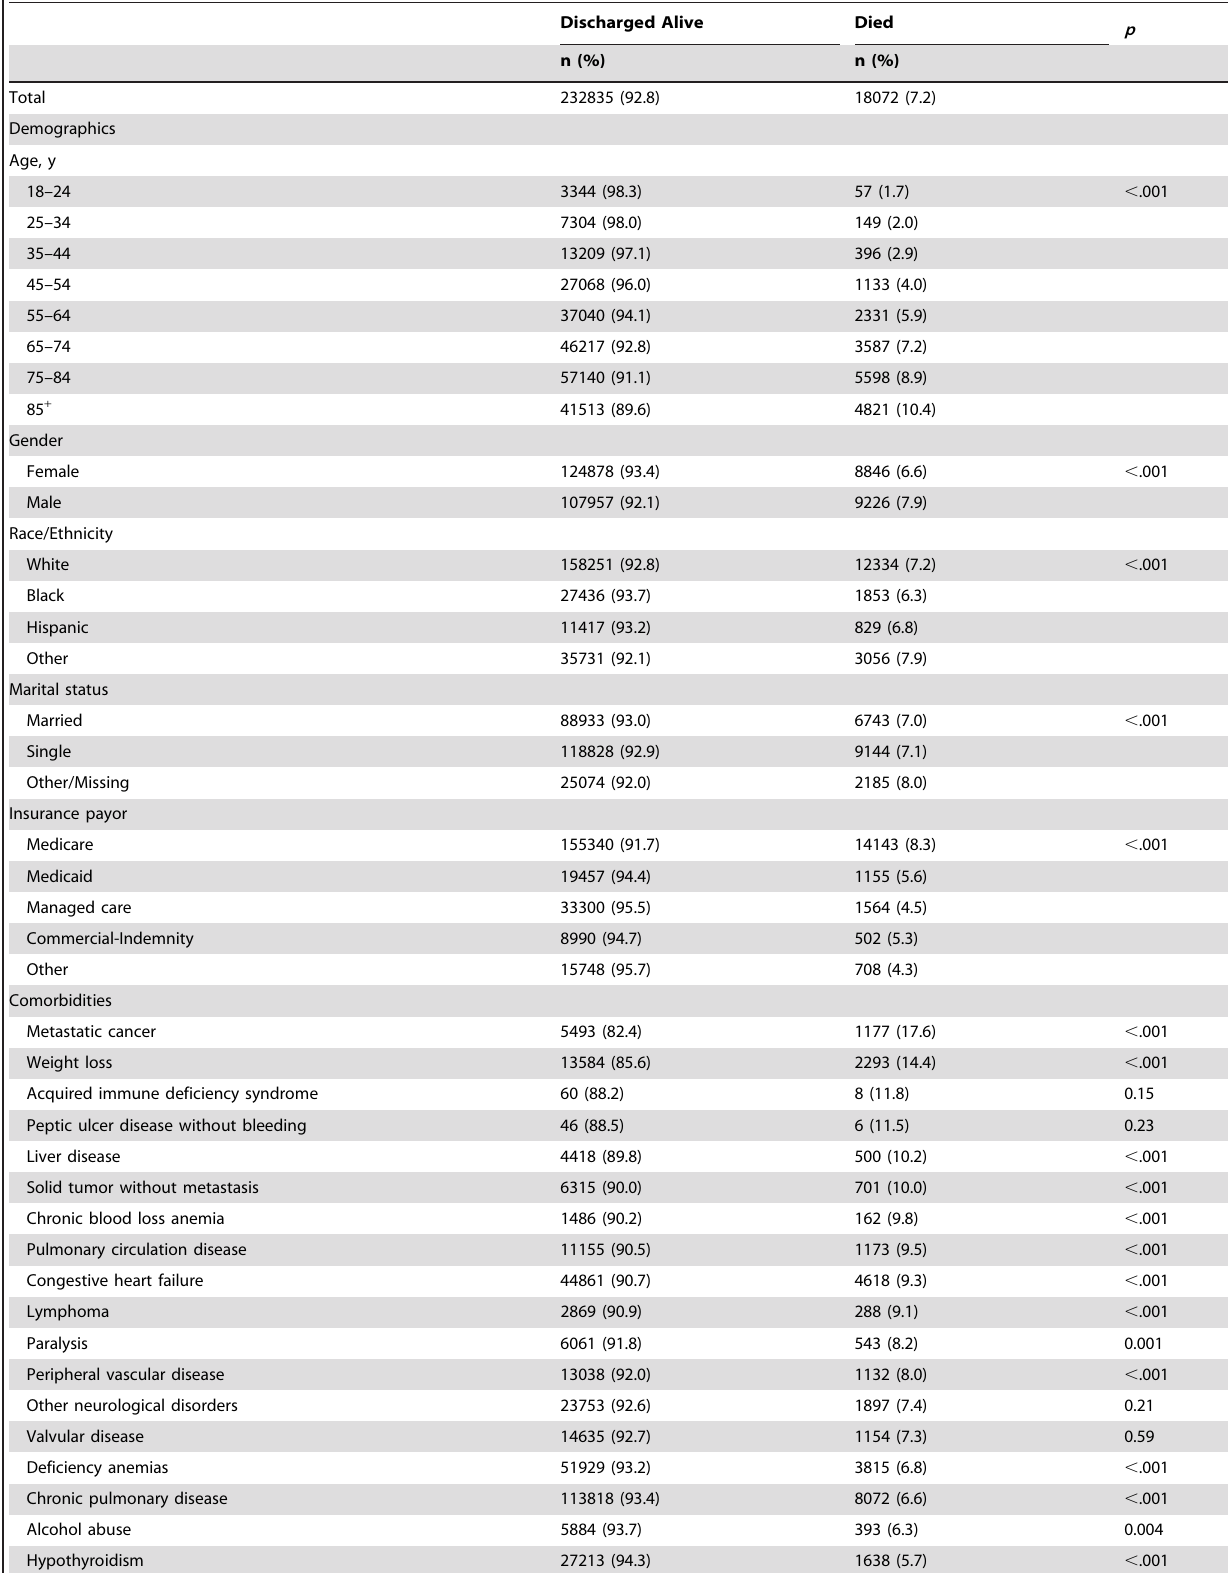
Table 1. Patient Characteristics Associated with Inpatient